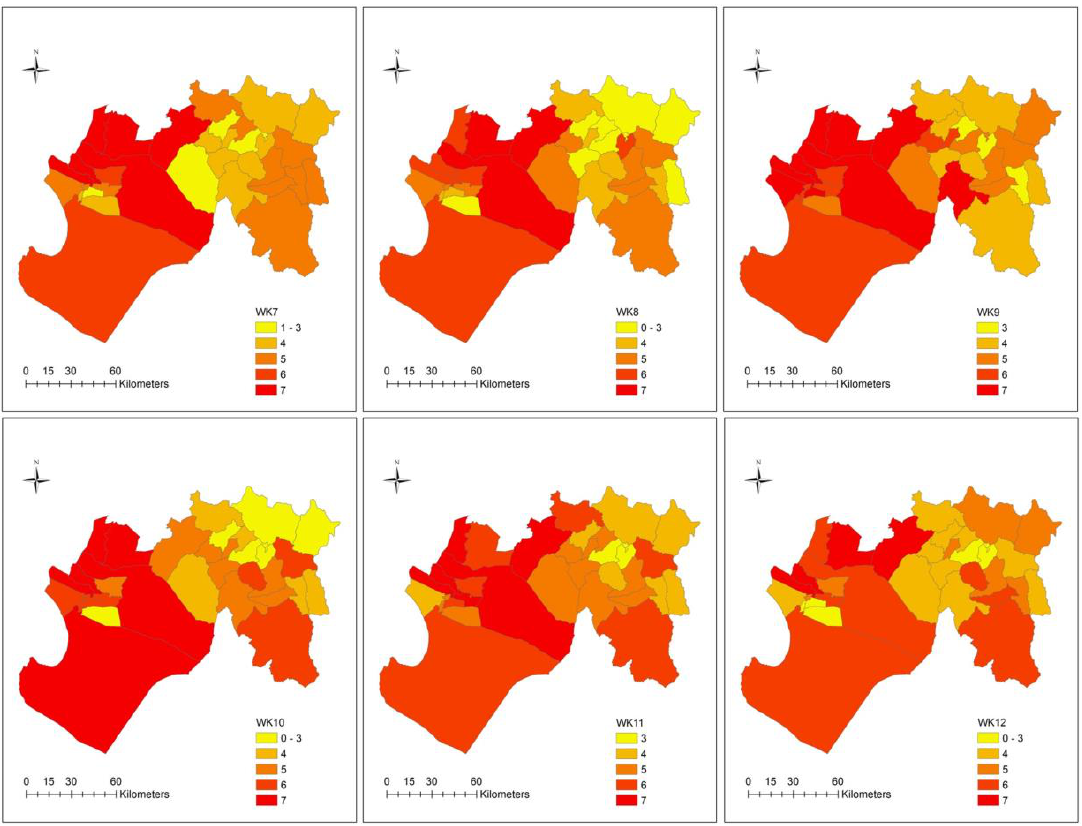
Figure 5. Maps of the number of overlapping diseases at the district-level by week, manual classification.